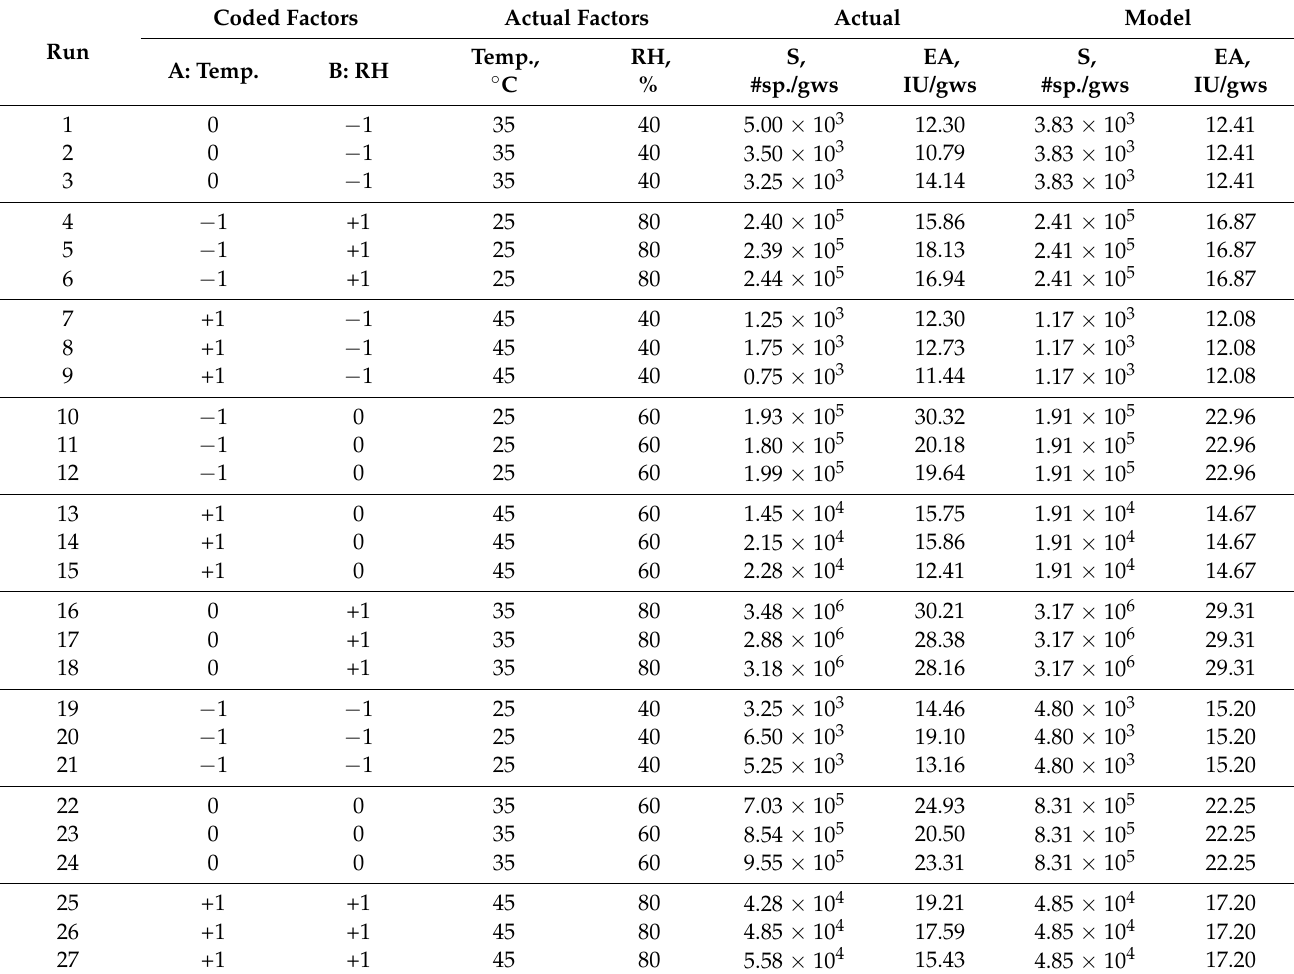
Table 2. Coded and actual factors and responses consisting in spore count (#sp.) and enzymatic activity in international units (IU) per gram of the wet substrate (gws) obtained from experiments of 3-level factorial